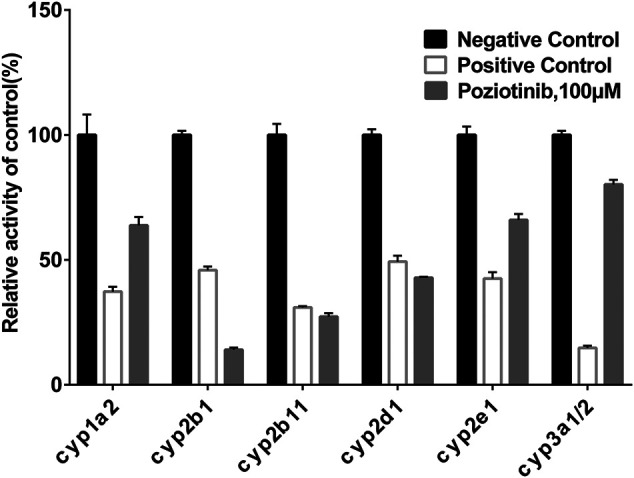
Inhibition of poziotinib on rat liver microsome. The concentrations of positive control inhibitors were as follows: 50 μM α-Naphthoflavone for cyp1a2, 50 μM Ticlopidine for cyp2b1, 20 μM sulfaphenazole for cyp2c11, 10 μM quinidine for cyp2d1, 100 μM sodium diethyldithiocarbamatre for cyp2e1, 1 μM ketoconazole for cyp3a1/2. Poziotinib was 100 μM. All data were mean ± SD of triplicate determinations.